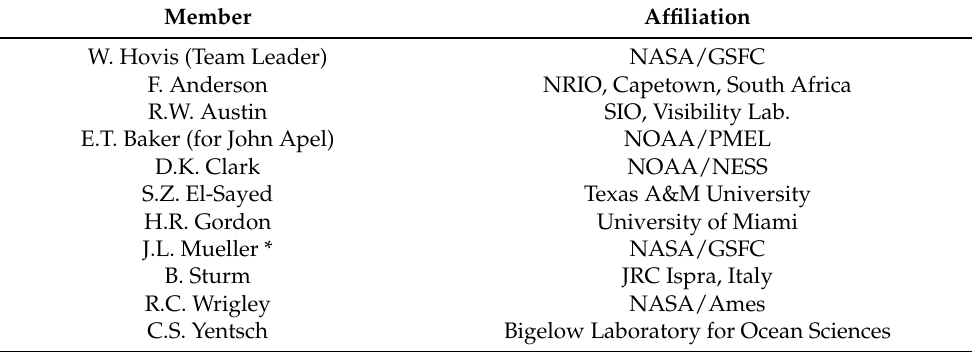
Table 1. Members of the CZCS Experiment Team selected in